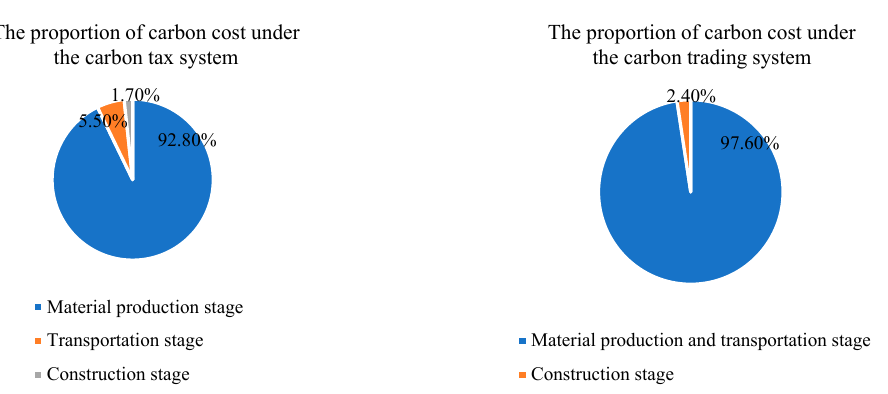
Figure 9. The proportions of carbon cost under the carbon taxing and trading systems.